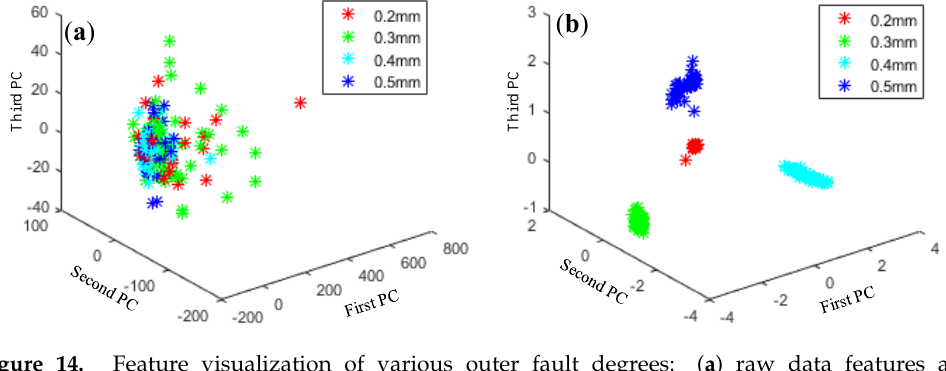
Figure 14. Feature visualization of various outer fault degrees: ( a ) raw data features and ( b ) proposed method.